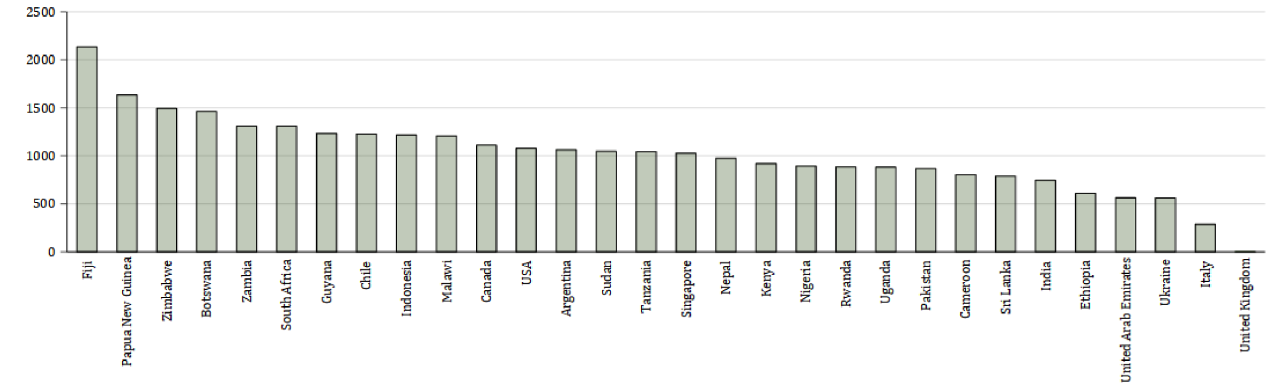
Figure 1. Mean emissions (in kg CO ) per country from air travel to Manchester and return. X axis shows the country from which the 2 students come – where students come from more than one city in the country, the mean has been calculated to characterise the country. Y axis shows kg CO 2